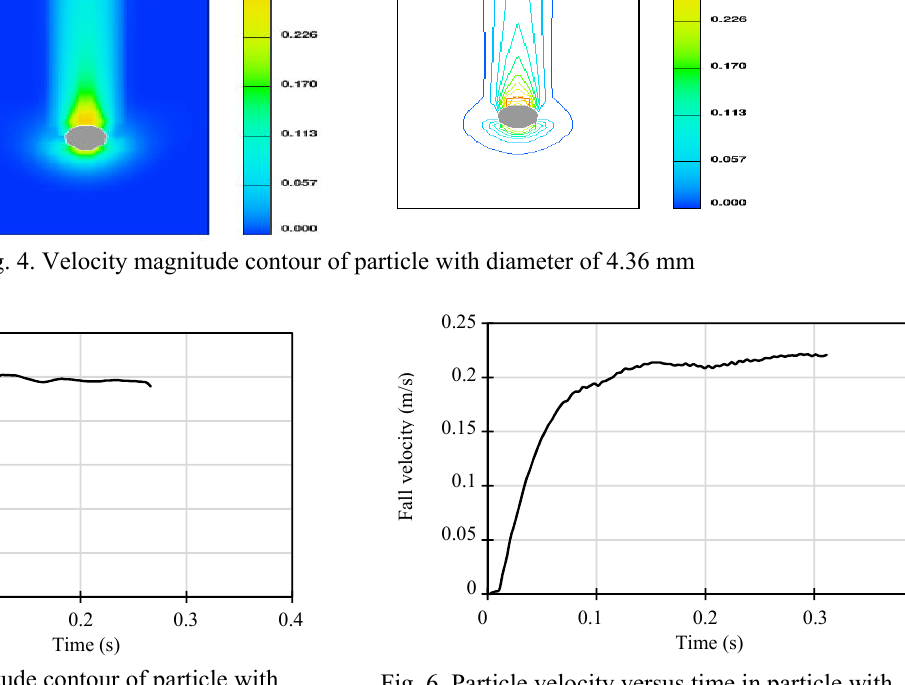
Fig. 6. Particle velocity versus time in particle with diameter of 1.09